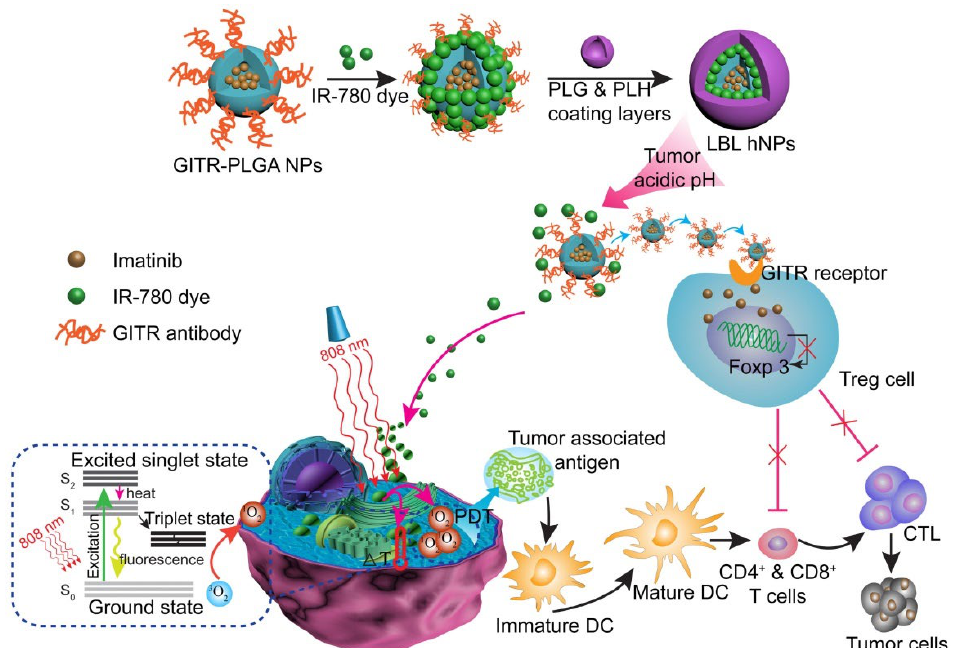
Figure 3. Schematic illustration of NIR therapy and regulatory T cell modulation using layer-by-layer hybrid nanoparticles. Adapted with permission from [123], published by Theranostics, 2018.